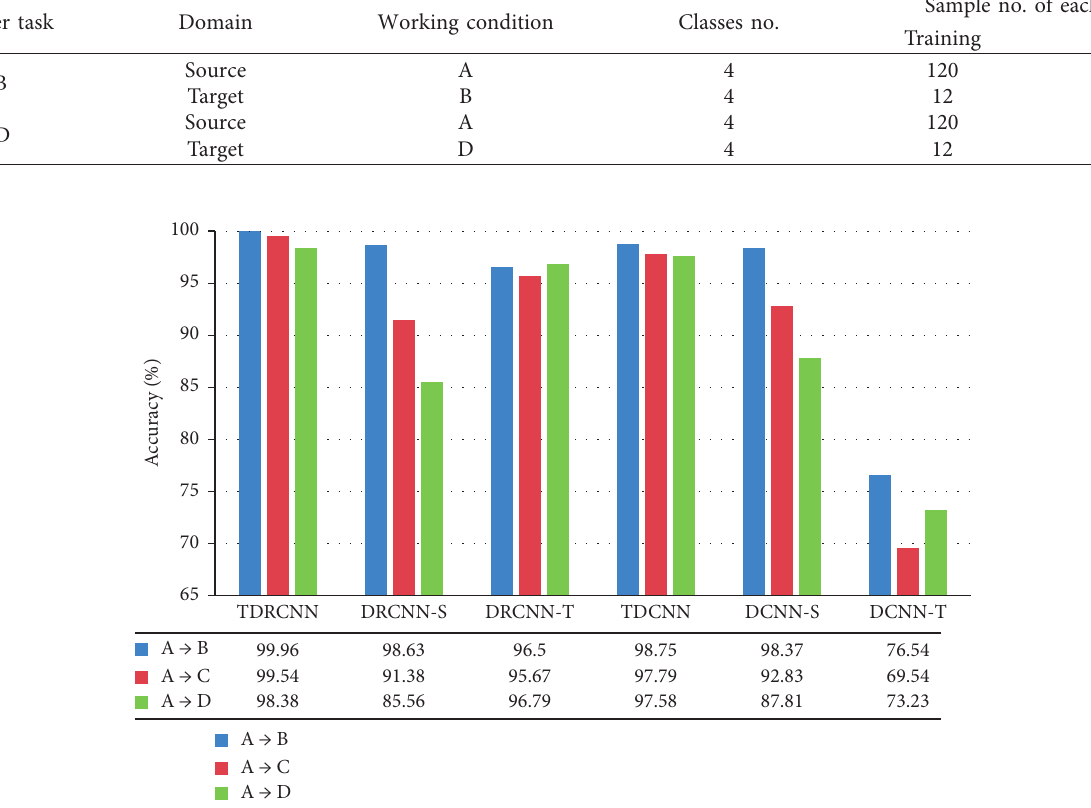
Figure 9: Performance comparison of different methods in the three transfer